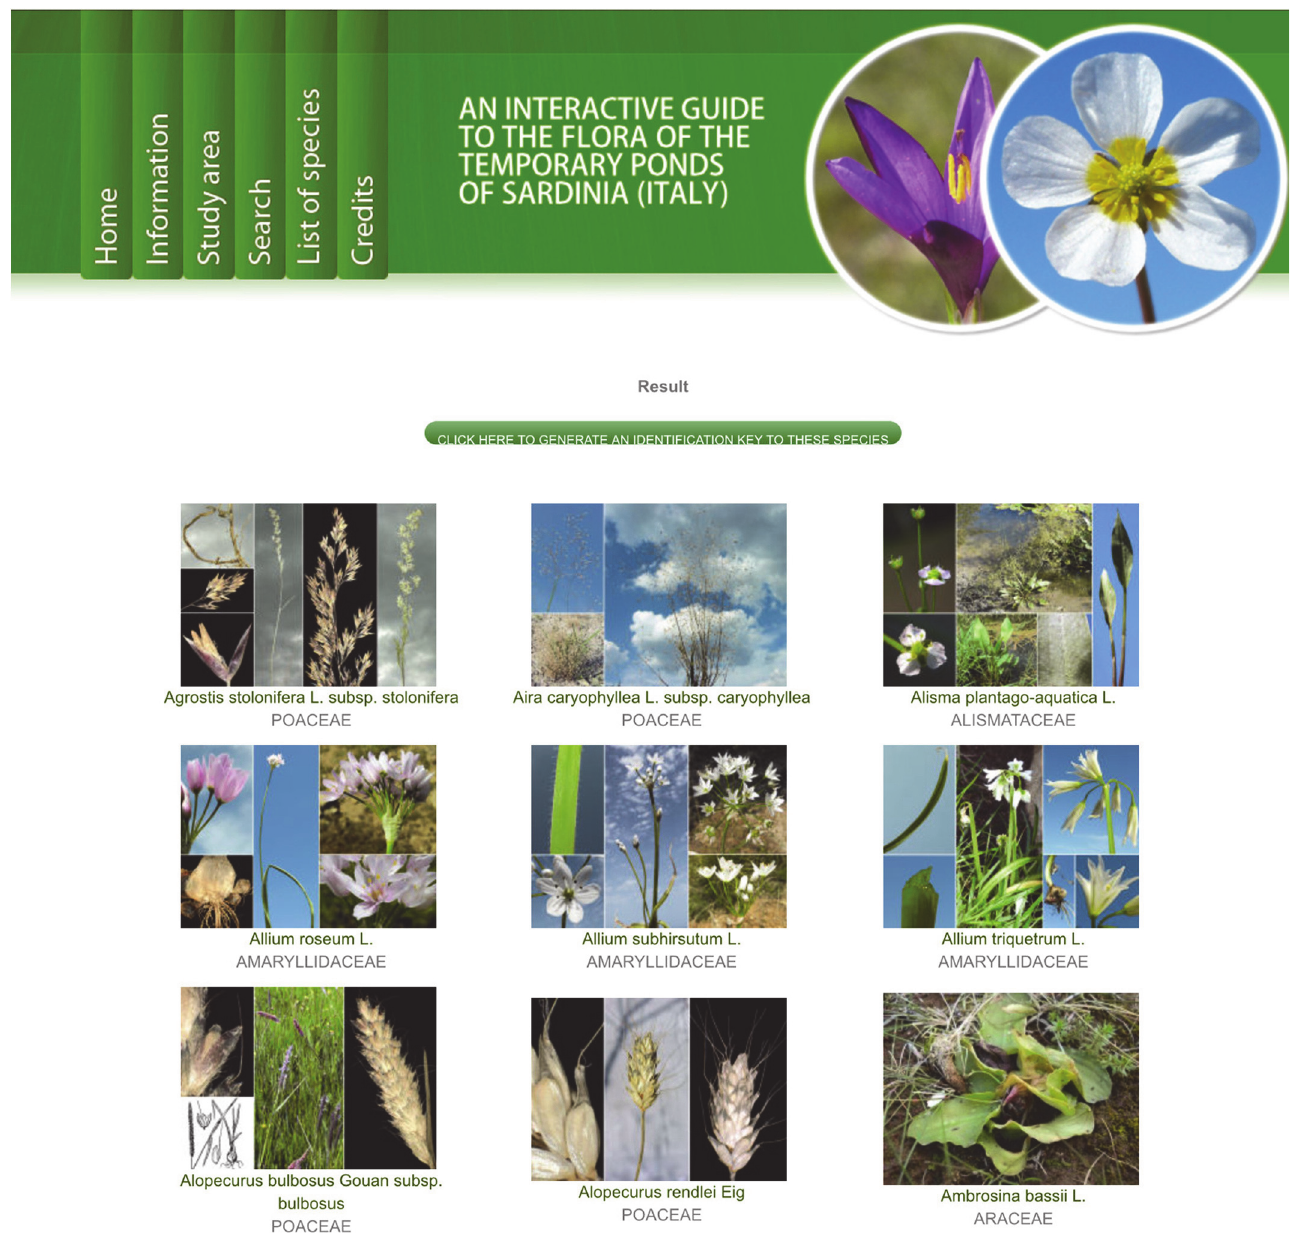
Fig 7. The multi-entry interface produces an illustrated gallery of taxa sharing the selected